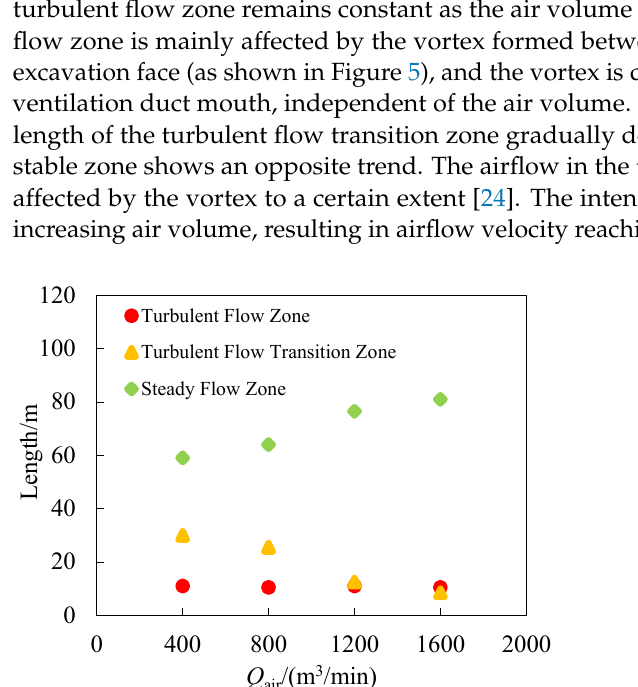
Figure 5. Longitudinal flow field diagram of single-ended tunnel.